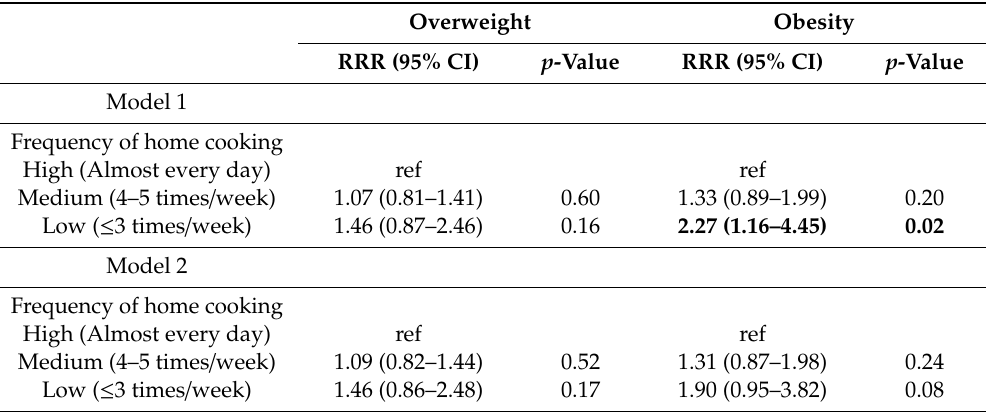
Table 3. Adjusted relative risk ratios of overweight and obesity according to the frequency of home cooking among school children in Japan ( n =